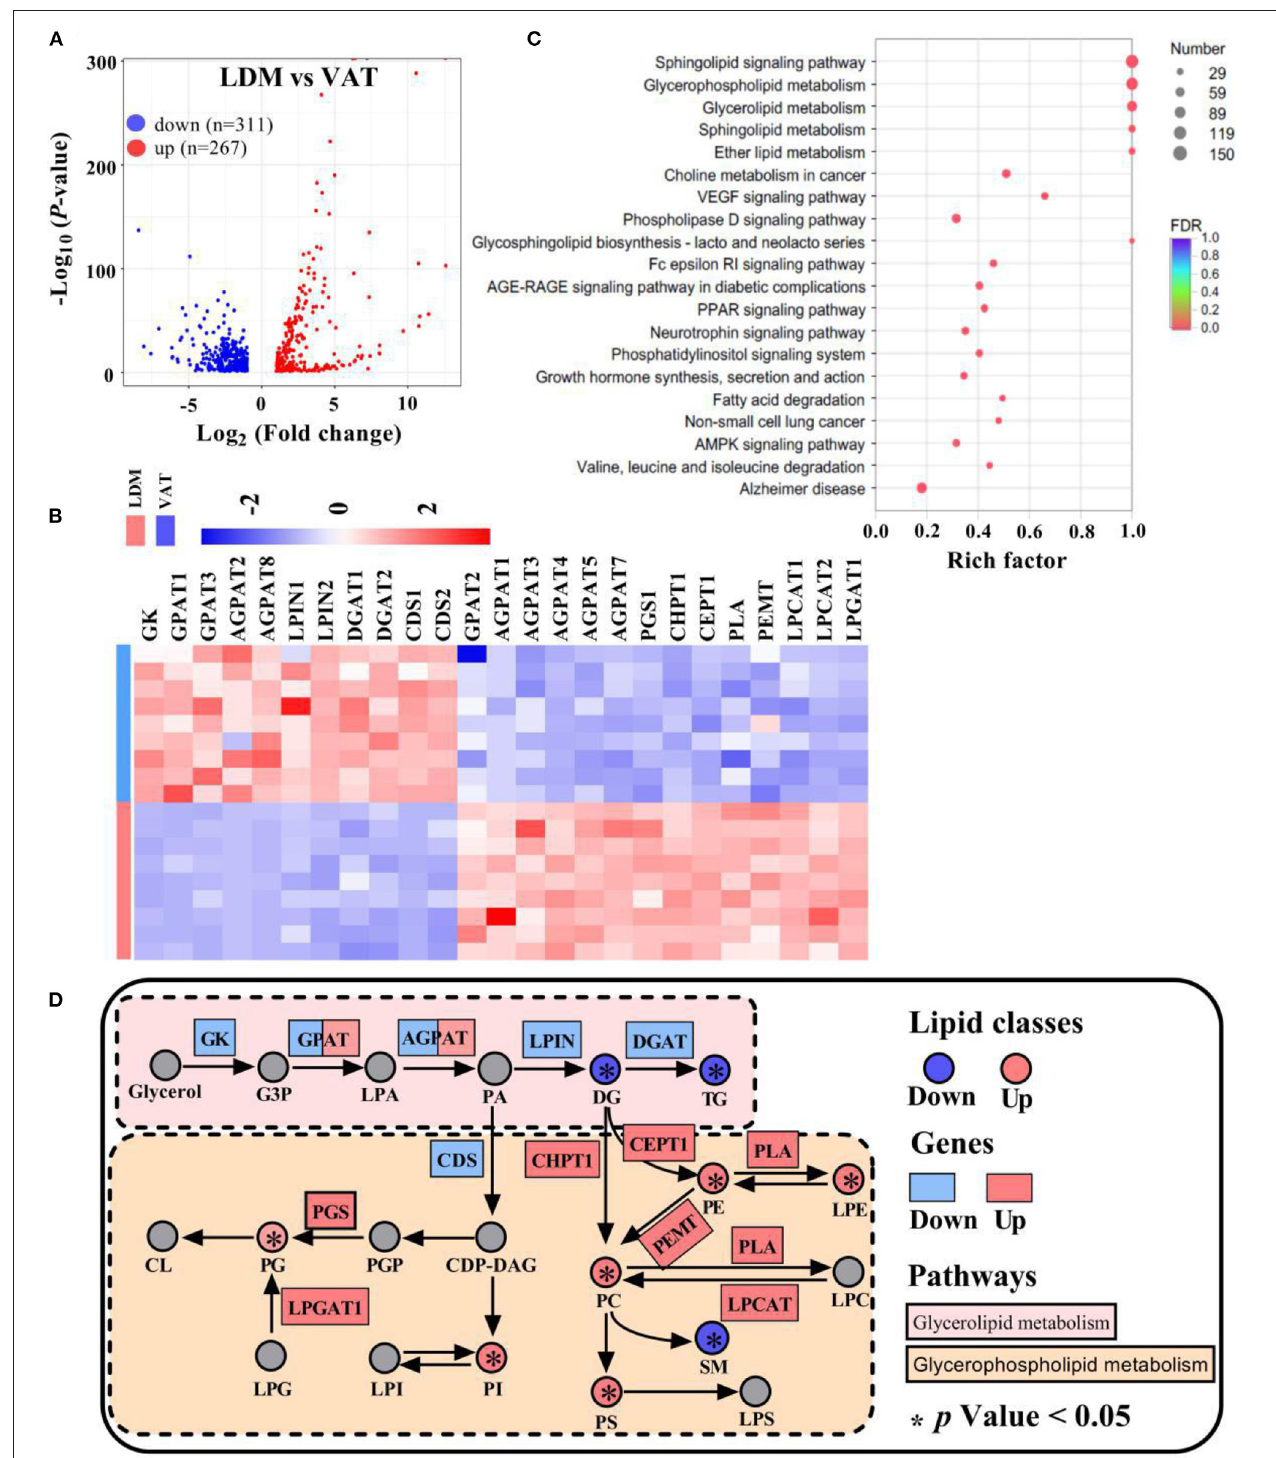
FIGURE 6 | Expression of lipid metabolism-related genes in LDM and VAT. (A) Differential expressed genes between LDM and VAT. (B) Heatmap of relative expression of selected major lipid metabolism-related genes in LDM compared with VAT. (C) KEGG enrichment pathways of different lipid metabolism-related genes in LDM compared with VAT. (D) Selected glycerolipid and glycerophospholipid metabolisms reactions from KEGG, with indications of lipid classes and genes significantly regulated in LDM compared with VAT.